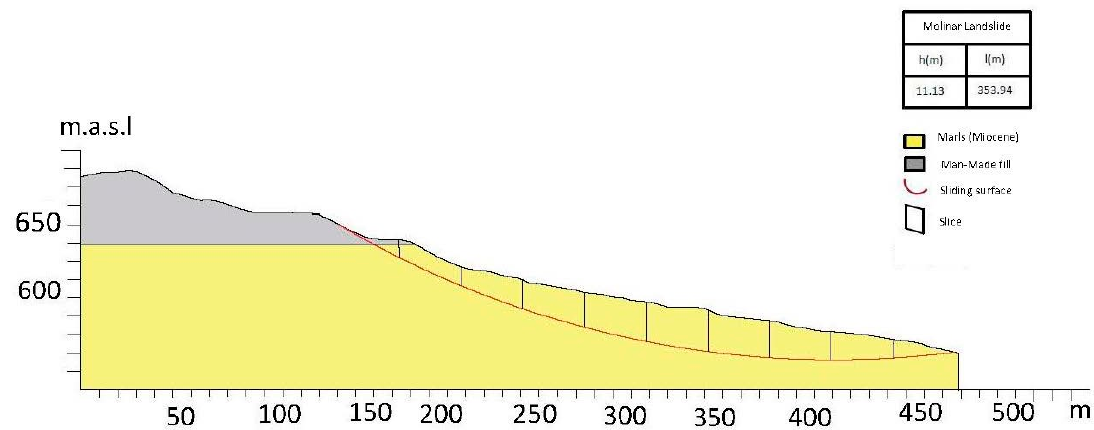
Figure 9. Example of simplified engineering-geology cross-section obtained for the Molinar landslide (see Figure 8 for location). The slices used for the GLE slope stability are also shown.